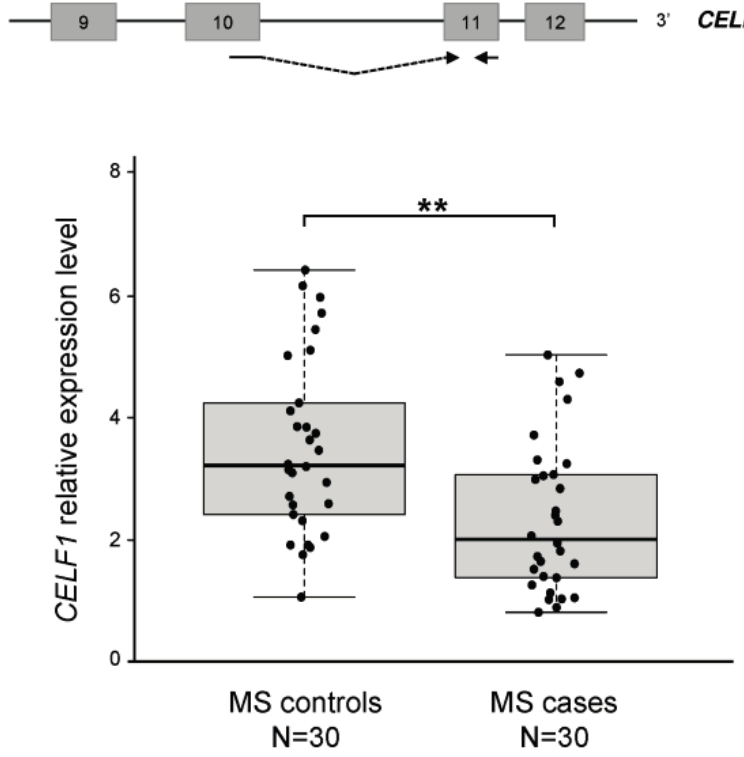
Figure 1. CUGBP Elav-like family member 1 ( CELF1 ) expression levels in peripheral blood mononuclear cells (PBMCs) of MS patients and controls. Expression levels were measured by semi-quantitative real-time RT-PCRs in 30 MS patients and 30 controls, using primers located in exons 10 and 11, as depicted in the scheme above boxplots. Boxplots show CELF1 expression levels according to disease status. Boxes define the interquartile range; the thick line refers to the median. Results are presented as normalized rescaled values. Significance level for differences between groups was calculated by a t -test. ** : p <